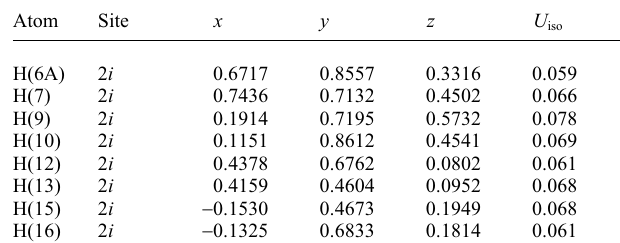
Table 2. Atomic coordinates and displacement parameters (in Å 2 ) . Table 2. continued